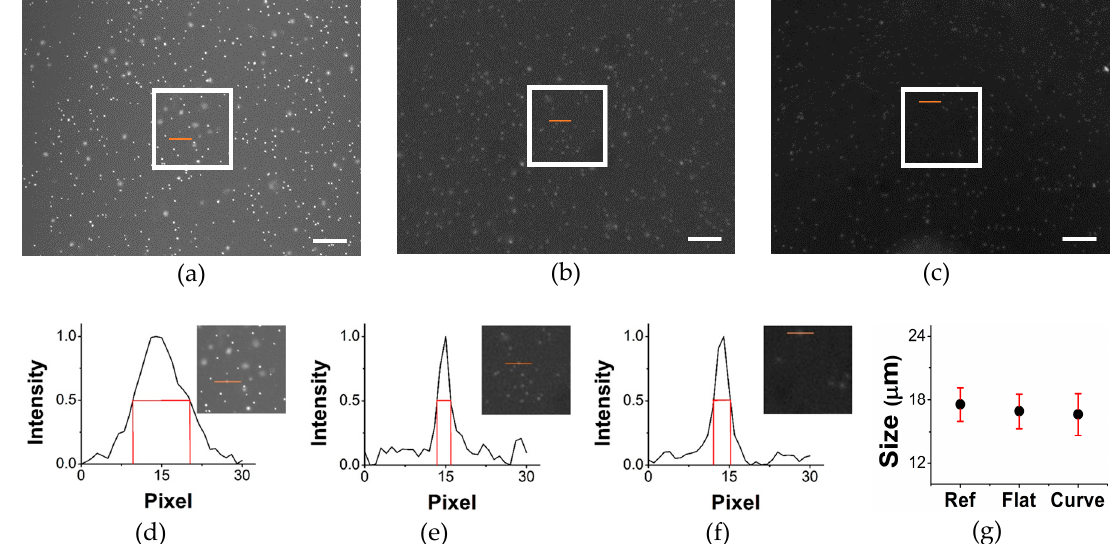
Figure 10. ( a – c ) The reference, flat, and curved chamber images with 500 µm 2 white boxes inside, respectively (scale bar = 0.5 mm); ( d – f ) the normalized intensity profiles of a fluorescently-labeled WBC in those three images; and ( g ) the size of the fluorescent WBCs measured with microscopy, and flat and curved imaging, represented by Ref, Flat, and Curved on the x -axis of the graph, respectively. The range of WBC size is 16–20 µm. The normalized intensity profile of the fluorescence shows the size of the SYTO-stained WBC in pixels, and the inset images are cropped from the center part of the processed image.